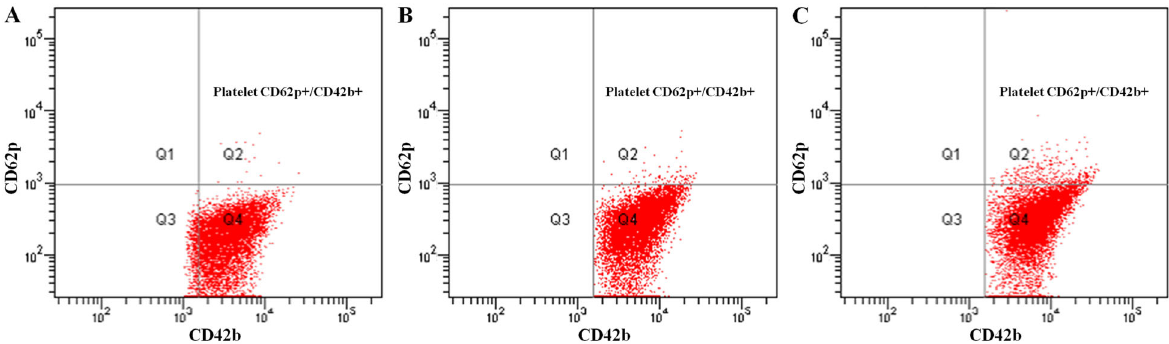
Figure 1. Results of the parameters of platelet CD62p. A , Normocholesterolemic volunteers. B , High levels of LDL-C combined with normal levels in HDL-C patients. C , High levels of LDL-C combined with low levels in HDL-C patients. LDL-C: low-density lipoprotein cholesterol; HDL-C: high-density lipoprotein cholesterol.